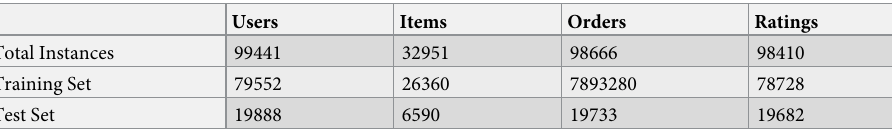
Table 1. Training and testing set for Brazilian E-Commerce